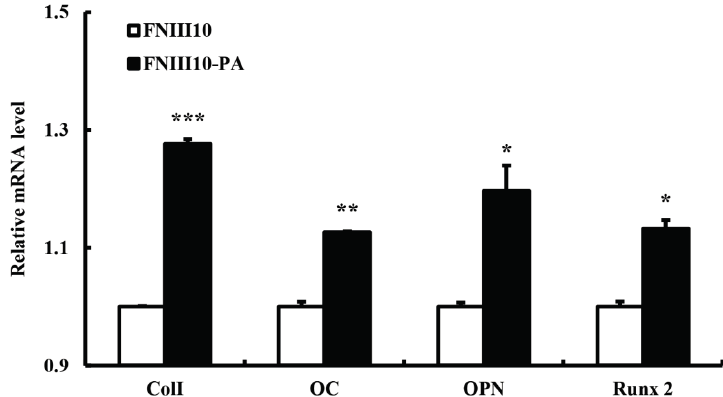
Figure 5. Osteogenic differentiation activities of FNIII10-PA on rMSCs at 7